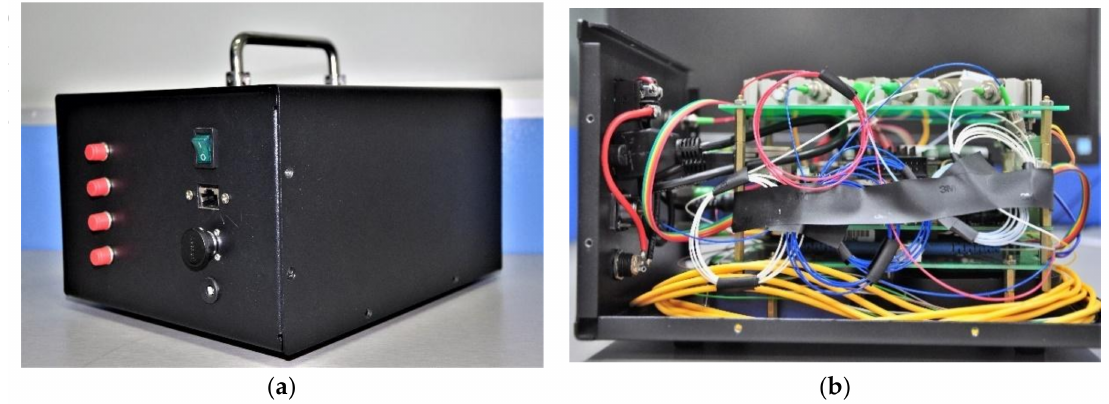
Figure 10. The FBG interrogation system: ( a ) external structure of the FBG interrogation system; and ( b ) internal structure of the FBG interrogation